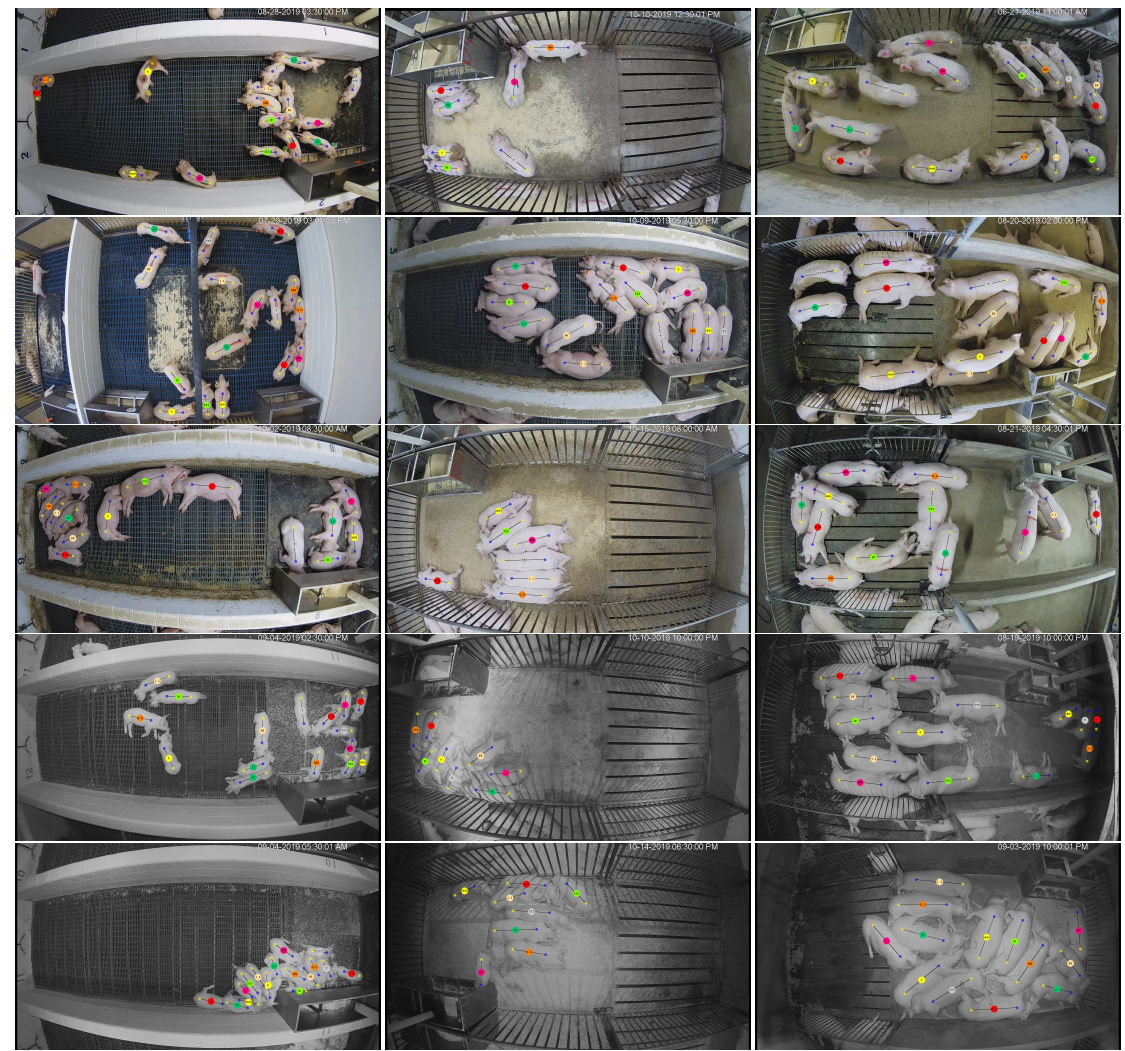
Figure 9. The first frames of the fifteen videos used to evaluate tracking performance. Annotations over each pig illustrate the position of the pig’s tail and shoulder along with the tag ID that each pig is equipped with (located between the shoulder and tail locations). The first column represents videos of the nursery phase (3–10 weeks old), the middle column represents the early finisher phase (11–18 weeks old), and the last column represents the late finisher phase (19–26 weeks old). The five rows correspond to high activity during the day, medium activity during the day, low activity during the day, medium activity during the night, and low activity during the